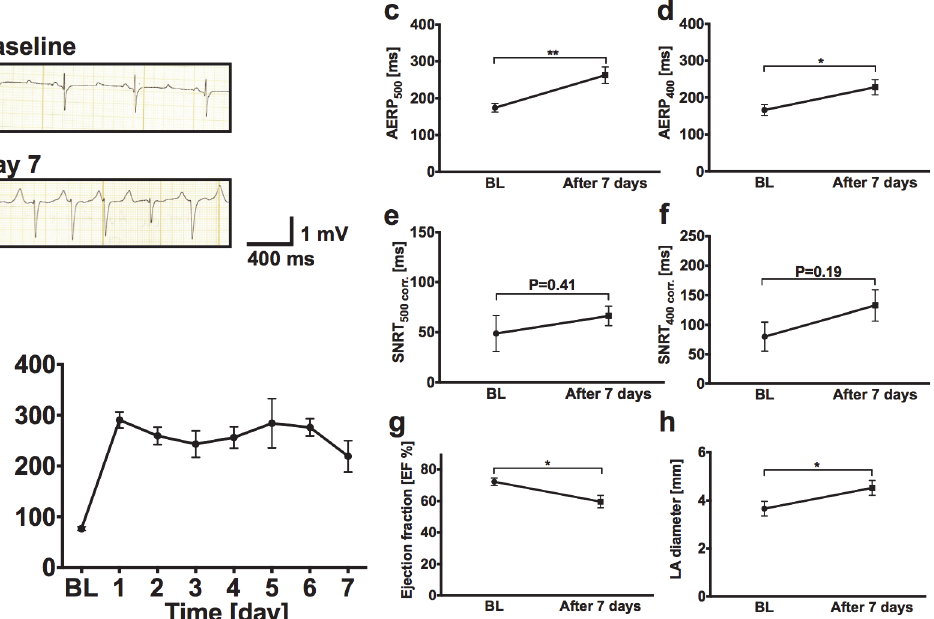
Fig 1. Clinical findings in AF pigs subjected to atrial tachypacing. a Representative ECG recordings at baseline and after atrial fibrillation (AF) induction by atrial burst pacing show sinus rhythm on day 0 and AF on day 7. b Mean heart rates assessed by daily ECG measurements from AF animals (n = 5). c-f Atrial effective refractory periods (AERP; c , d ) and corrected sinus node recovery time (SNRT; e , f ) at baseline and prior to euthanization at day 7 in AF pigs (n = 5). g, h Echocardiographic analysis of left ventricular ejection fraction (EF) and left atrial (LA) diameter. Data are given as mean ± SEM; * P < 0.05; ** P <